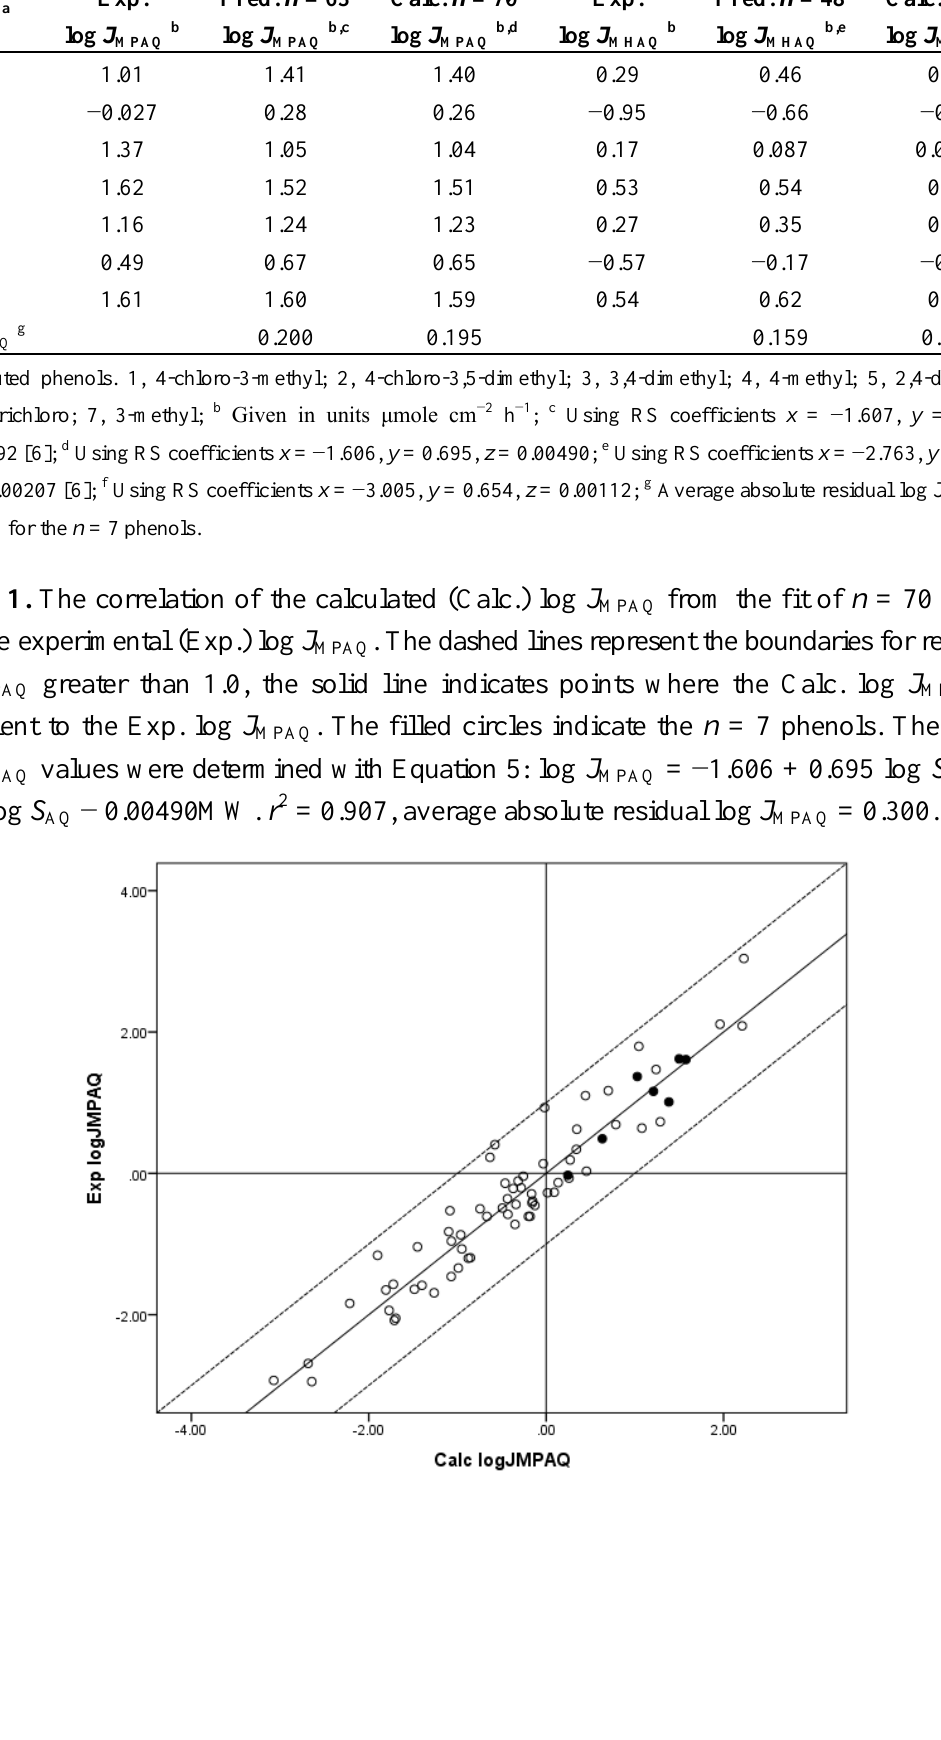
Table 2. The calculated (Calc.), predicted (Pred.), and experimental (Exp.) maximum flux values through silicone from water (log J ) and through human stratum corneum from MPAQ water (log J ) for the n = 7 phenolic compounds. MHAQ Cmpd. a